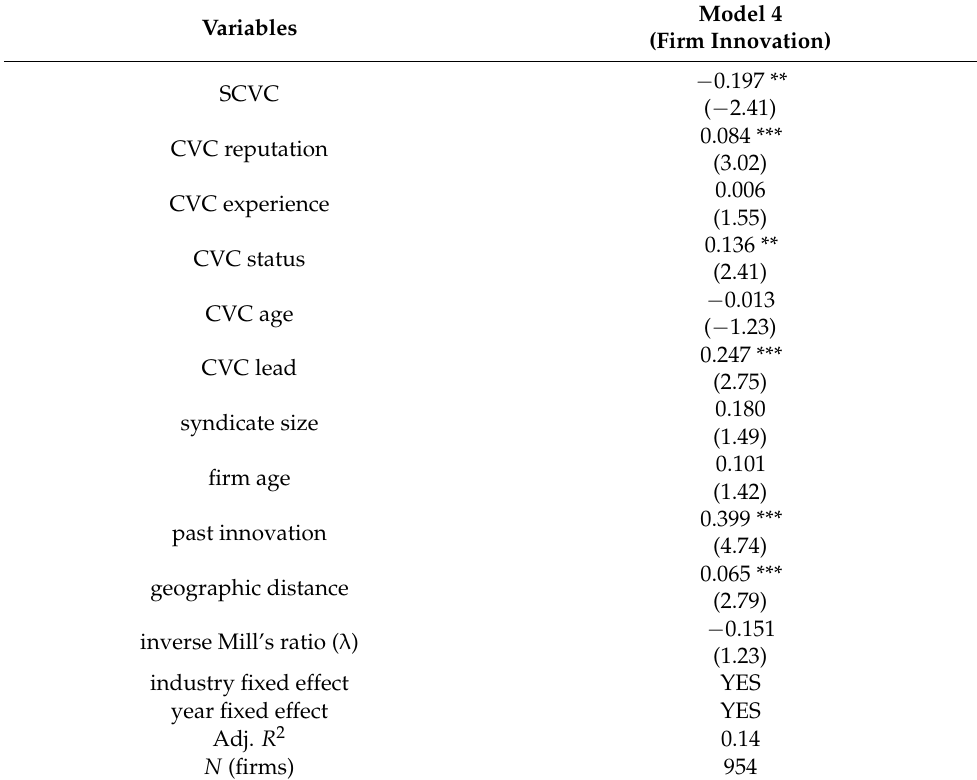
Table 5. Second-stage OLS model: innovation of startups.